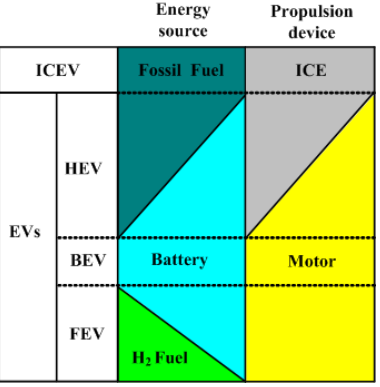
Figure 1. EV classification. ICEV, internal combustion engine vehicle; HEV, hybrid electric vehicle; BEV, battery-powered electric vehicle; FEV, fuel cell electric